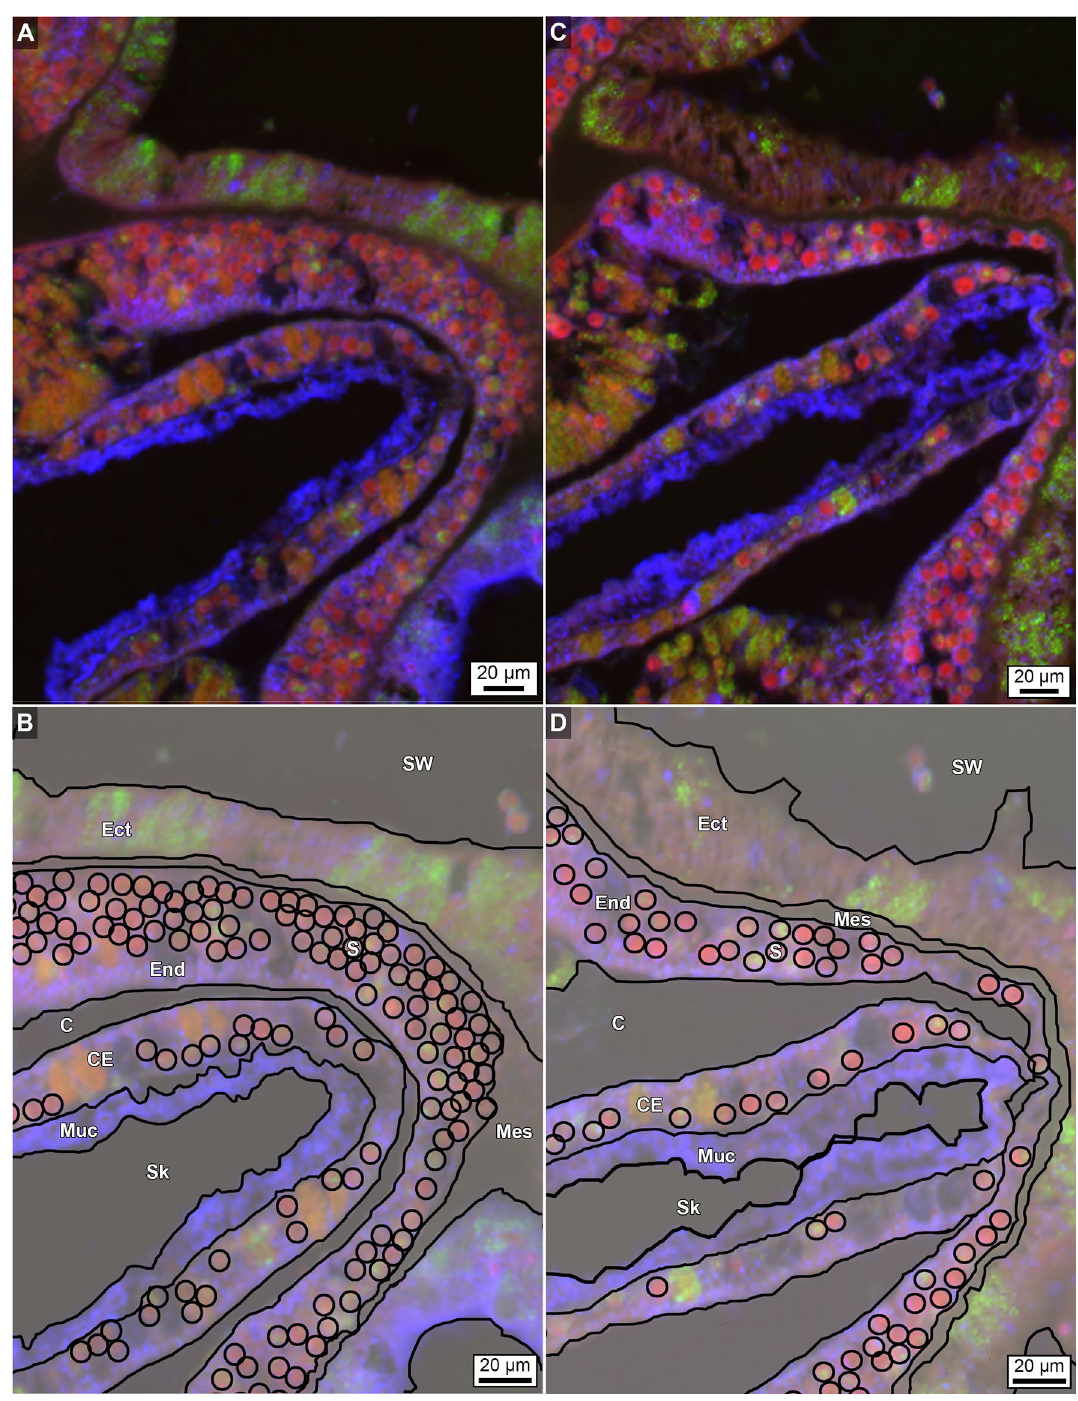
Figure 7. Enlargement of immunohistochemical fluorescence microscopy of the distributions and abundance of carbonic anhydrase, calmodulin and mucus within tagged polyp tissues of O. faveolata . ( A ) Original enlarged image (from box 7A-B shown in Fig. 6A) of a horizontal cross-section of decalcified polyp tissues of O. faveolata collected in March 2008 exhibiting superimposed emissions from mucus (blue fluorescence), carbonic anhydrase (green fluorescence), and calmodulin (red fluorescence). ( B ) Line tracing of A indicating individual Symbiodiniaceae. ( C ) A second enlargement (from area shown in Supplementary Figs. S5, S6) image of a horizontal cross-section of decalcified polyp tissues of O. faveolata collected in May 2008 exhibiting superimposed emissions from mucus (blue fluorescence), carbonic anhydrase (green fluorescence), and calmodulin (red fluorescence). ( D ) Line tracing of C indicating individual Symbiodiniaceae are found in both the oral endoderm and the calicoblastic epithelium. Labels include: End—endoderm; Mes—mesoglea; Ect— ectoderm; Muc—mucus; PS—primary septum; SW—seawater at the time the polyps were collected; and Sk— skeleton. Tissue structure terminology follows nomenclature in Allemand et al 54 and Peters 55